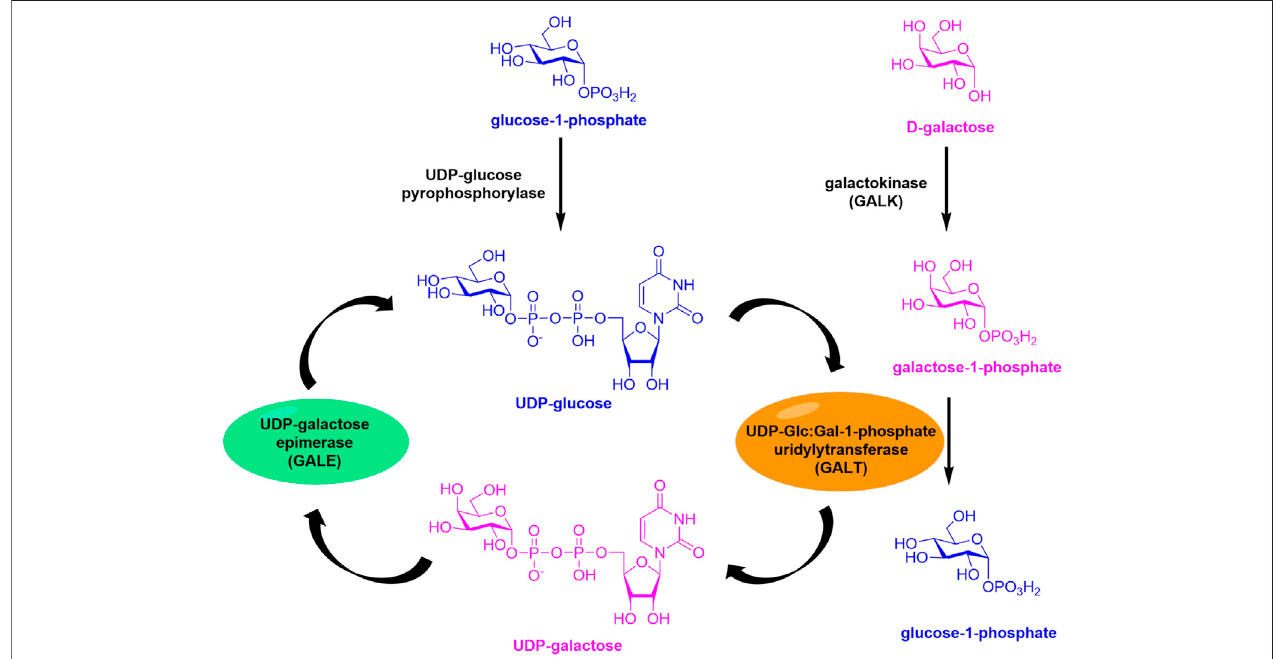
SCHEME1| Leloirpathwayofthegalactosemetabolism.ThehighlyconservedLeloirpathwayiscomposedofthreeenzymes:galactokinase(GALK),galactose-1- phosphate uridylyltransferase (GALT), and UDP galactose 4 ′ -epimerase (GALE).